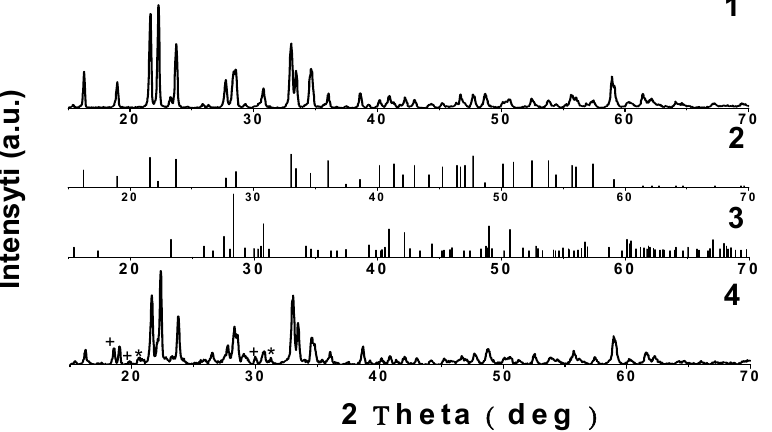
The interaction between Li 3 . 8 Ge 0 . 9 S 0 . 1 O 4 solid electrolyte and metallic lithium was evaluated based on determining the change in the resistance of Li │ Li 3 . 8 Ge 0 . 9 S 0 . 1 O 4 │ Li symmetrical cell. The cell was held at 100 ° С for 240 h. During the isothermal exposure, the cell was periodically cycled ( − 4 V... +4 V, 20 mV/s). Measurements of the electrical re- sistance of the cell performed by the pulse method as well as by the impedance spectros- copy method after isothermal exposure (Figure 9) showed that the conductivity of Li|Li 3 . 8 Ge 0 . 9 S 0 . 1 O 4 |Li cell did not change within the uncertainty of the experiment. After the experiment, the solid electrolyte sample was weighed and examined under the microscope. The weight and the color of the sample did not change. The results of the conductivity measurement suggest that no observable interaction between Li 3 . 8 Ge 0 . 9 S 0 . 1 O 4 and metallic lithium takes place under the conditions of the experiment.